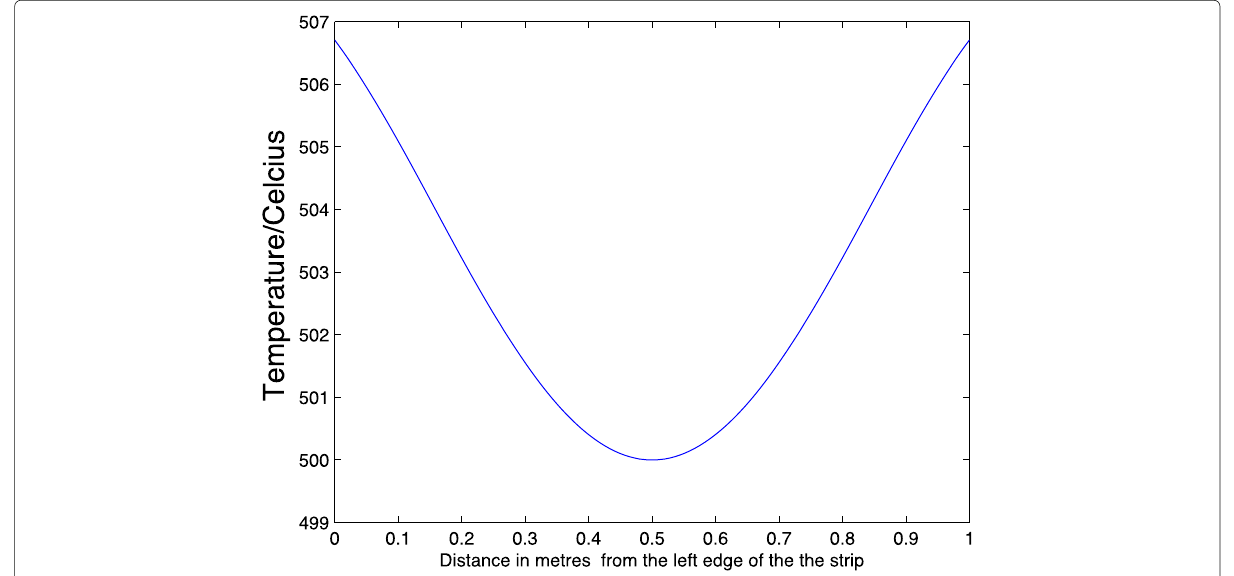
Fig. 13 The predicted temperature variation T S across the strip